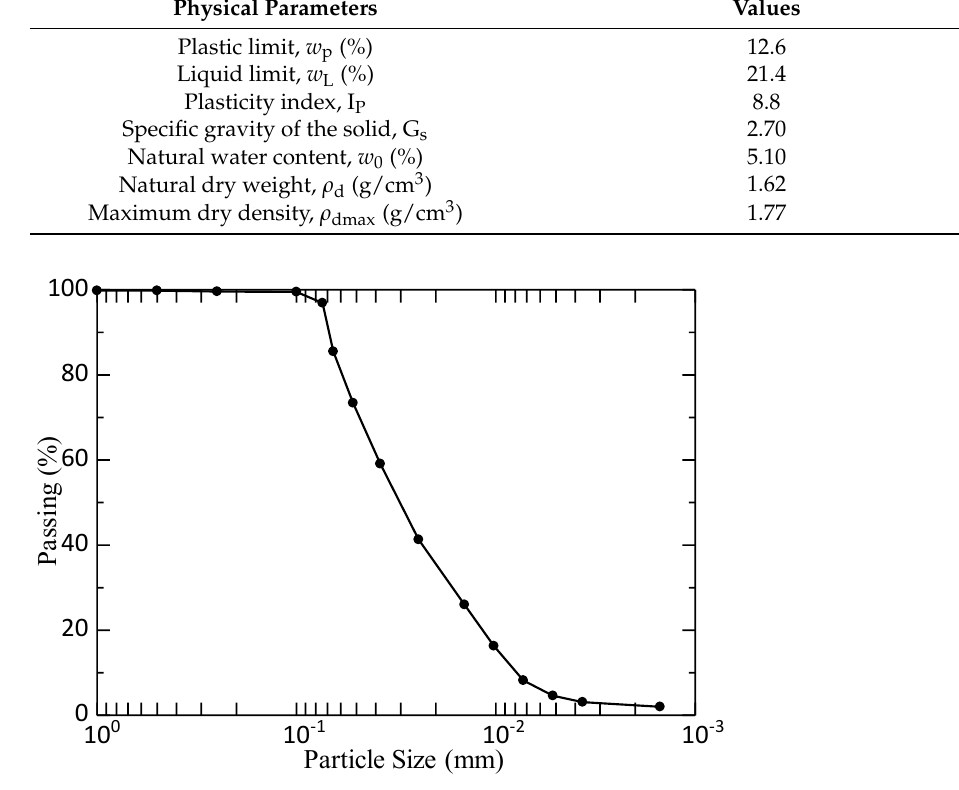
Figure 3. Grading curve of the silt.